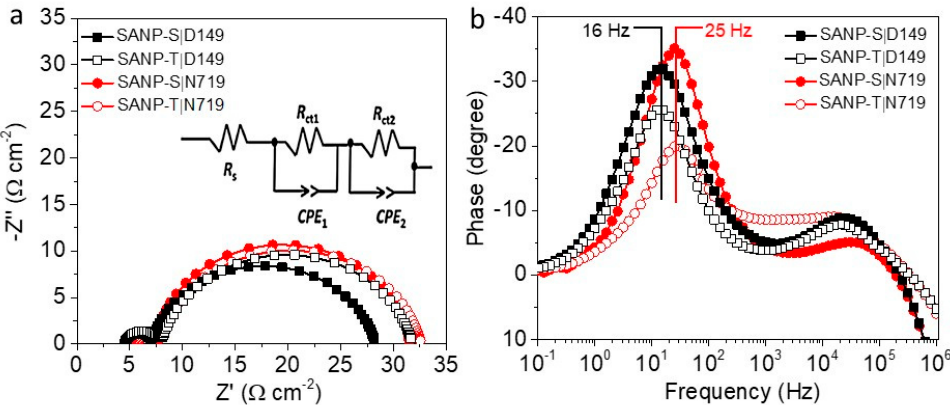
Figure 7. Electrochemical impedance spectroscopy (EIS) measurements. ( a ) Nyquist and ( b ) Bode plots of devices based on SANP-S and SANP-T sensitised with either D149 or N719.